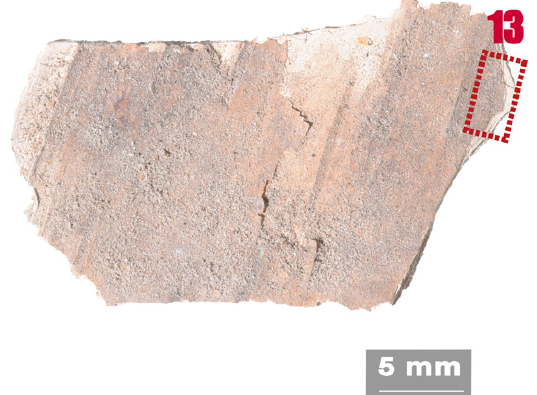
Figure 7. Sample 13 was extracted from a birch bark fragment recovered in the Kosackenberg cave. Inner and outer surfaces have reddish-brown overlay with white blooming. Normally alternating white and reddish-brown layers are not present, as reddish-brown colouring of thick-walled cells is completely lost. Lenticels have also lost their normally dark colour and are hardly distinguishable from normal phellem. Fragment is very light and extremely fragile; handling leads to fragmentation and loss.